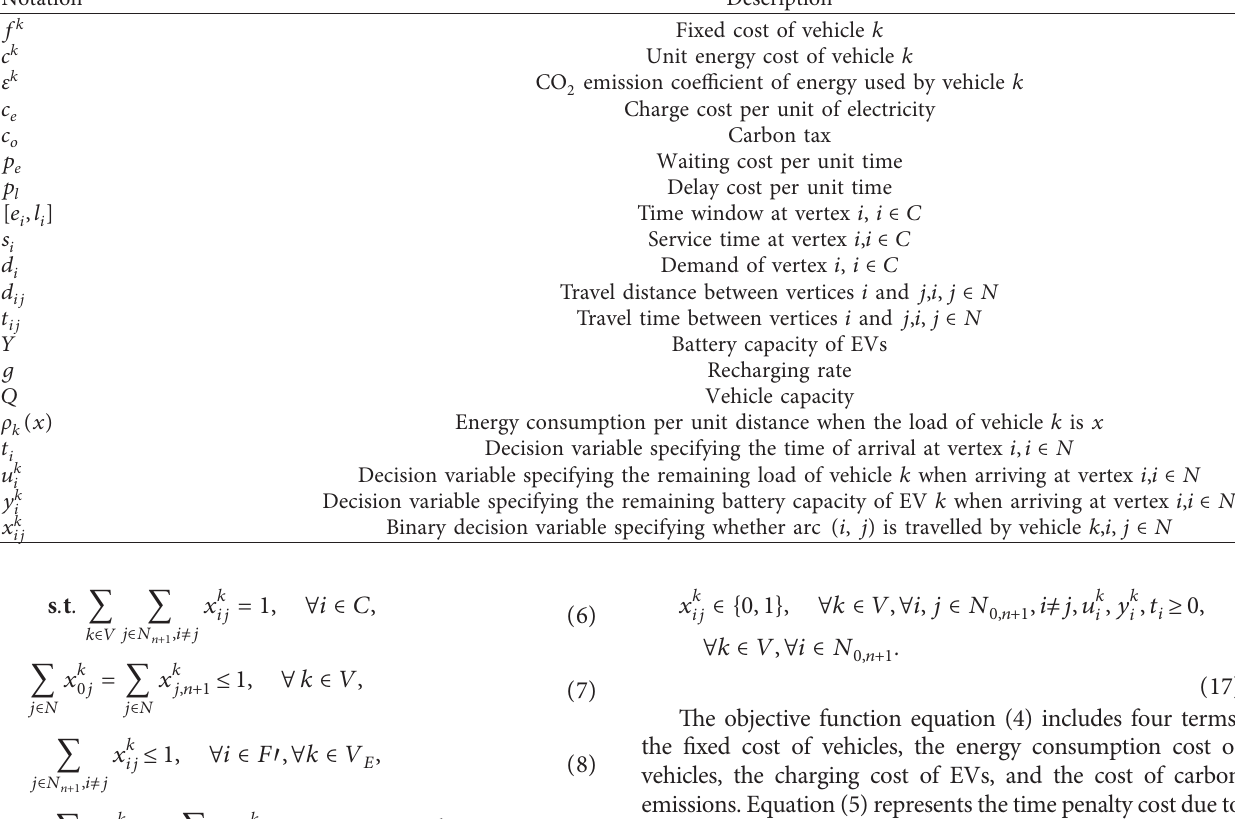
Table 2: Parameter and variable definitions of the